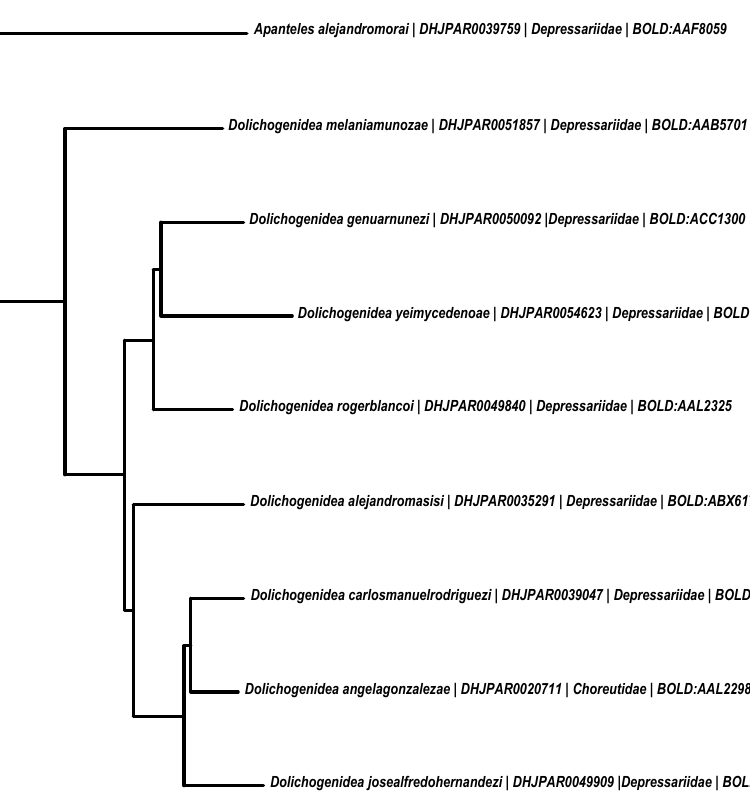
Figure 9. A neighbour-joining tree representing the interspecific variation in the DNA barcode region for the holotypes of the Dolichogenidea species described in this paper. The tree was built in MEGA X (Kumar et al. 2018) based on the K2P model (Kimura 1980). Tip labels are: Species name | Voucher code | Host family | BIN number in BOLD. The holotype of the morphologically similar, but genetically quite diverse, Apanteles alejandromorai Fernandez-Triana is included to demonstrate the large genetic divergence between the two genera (nearly